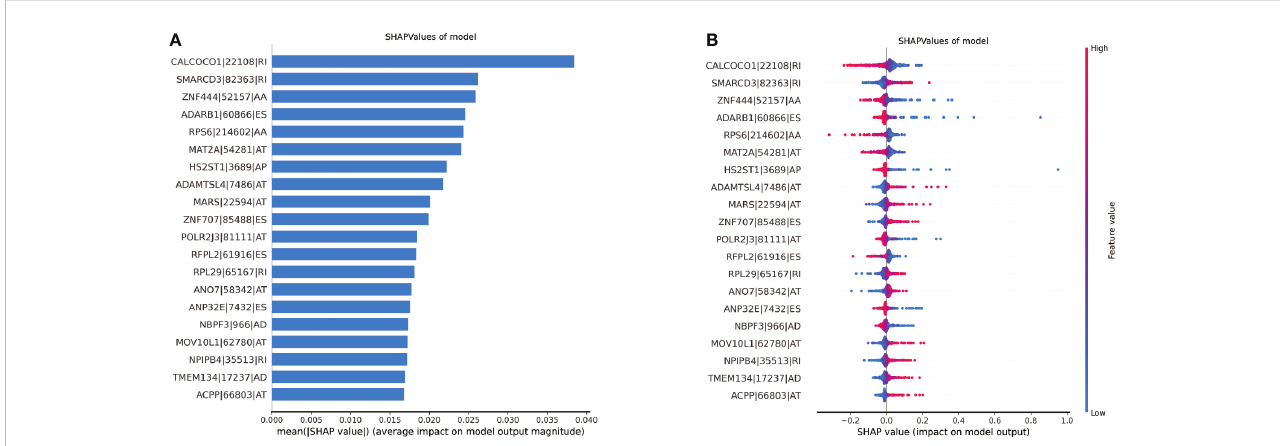
FIGURE 5 Illustration of the top 20 features contributing to model output by SHAP values. (A) The relative contributions of each of the parameters to predict the risk of lymph node metastasis. (B) The relative contributions of each feature for model prediction. Features on the right of the risk explanation bar pushed the risk higher, and features on the left pushed the risk lower.